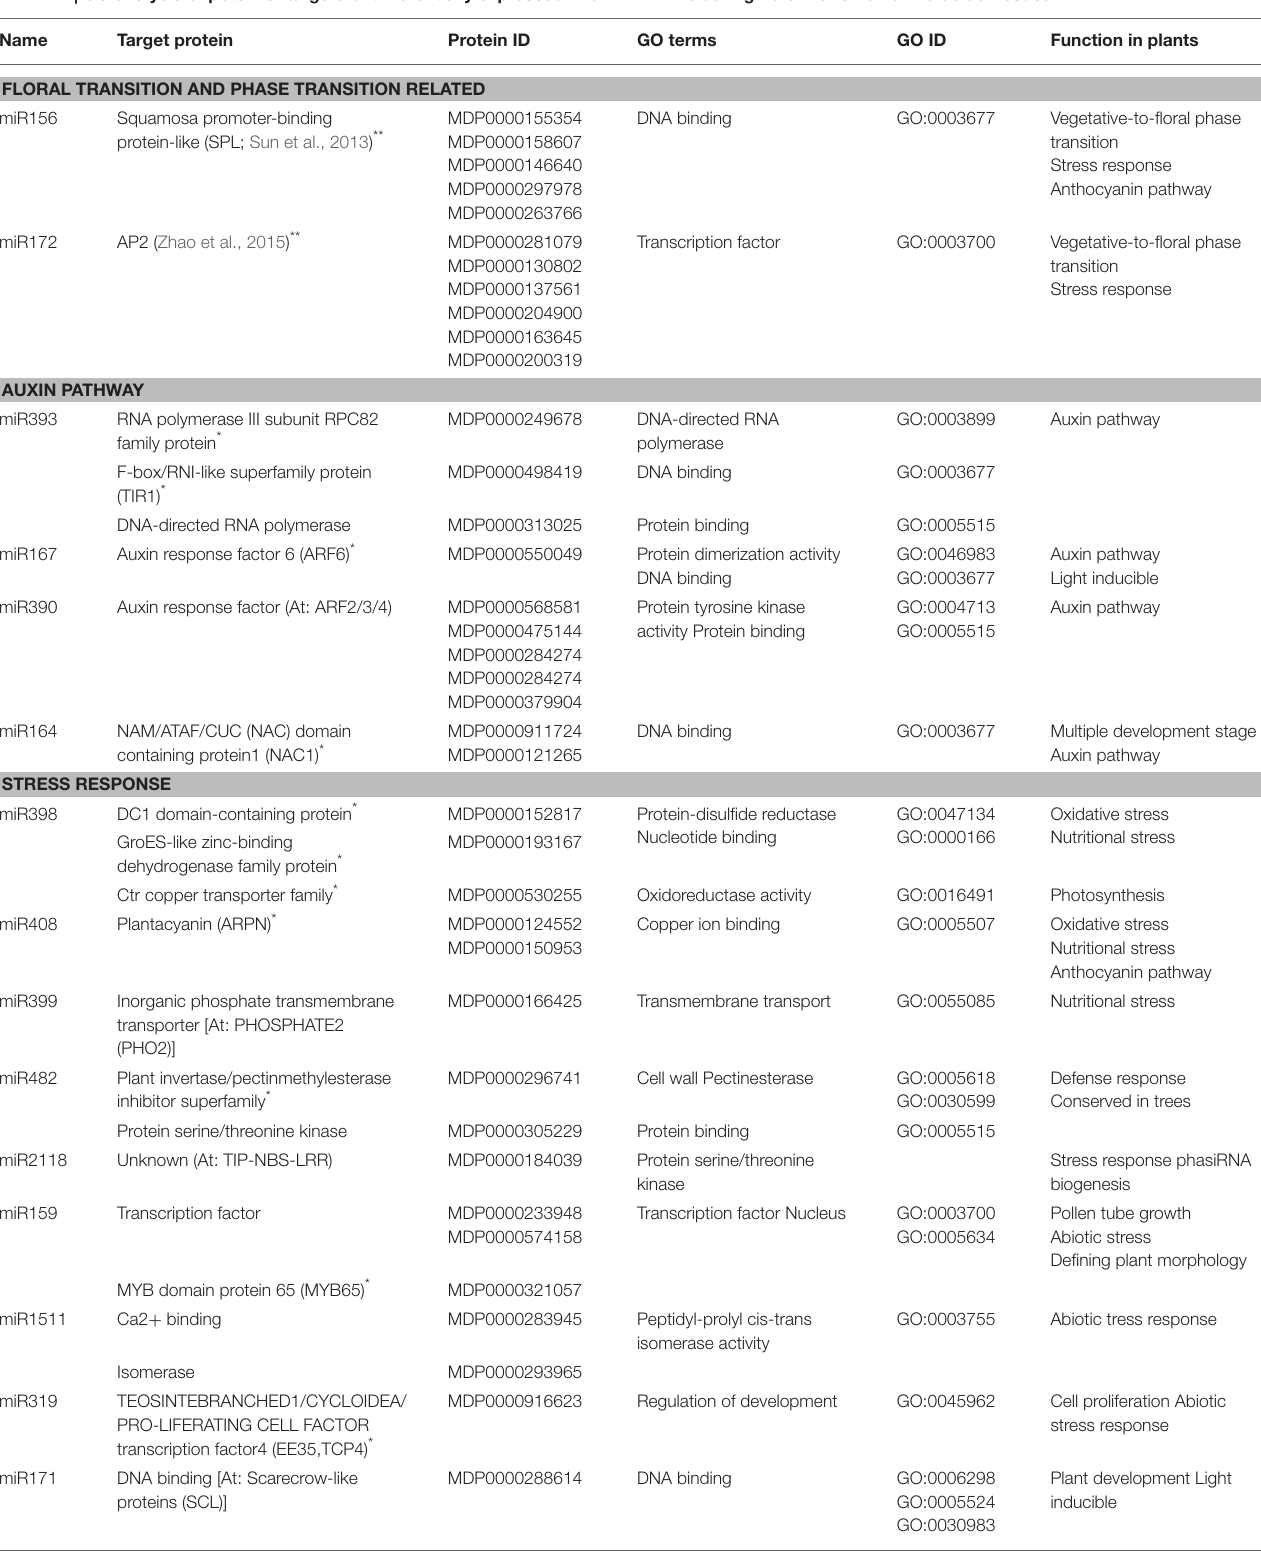
TABLE 2 | GO analysis of potential targets of differentially expressed known miRNAs during floral transition of Malus domestica . Name Target protein Protein